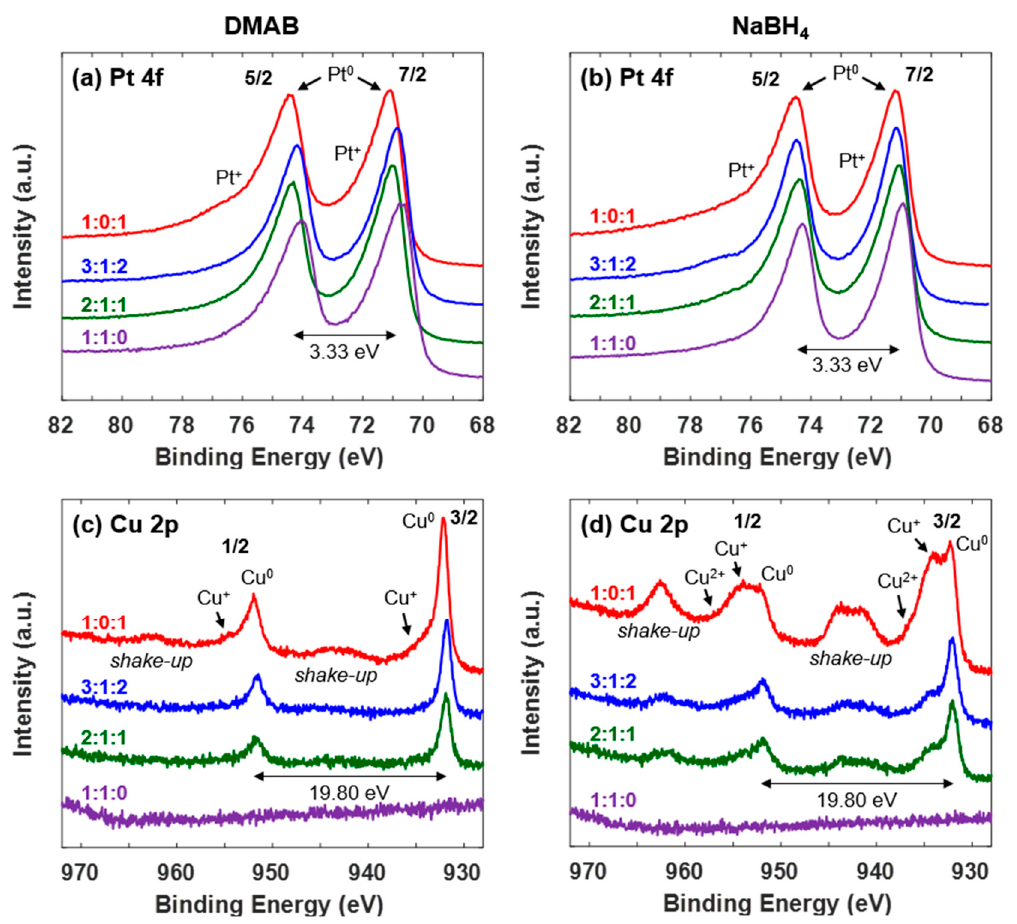
Figure 6. X-ray photoelectron spectra (XPS) for Pt–Cu macrotubes–macrobeams synthesized